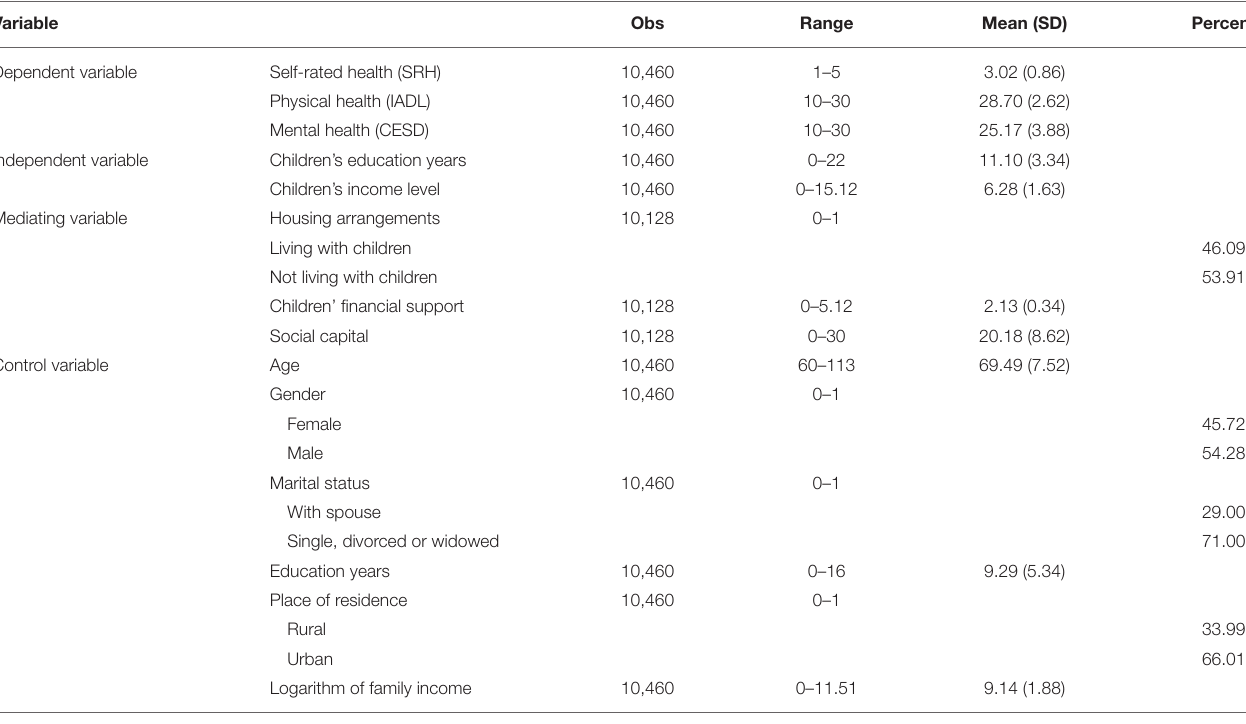
TABLE 1 | Basic characteristics of variables.